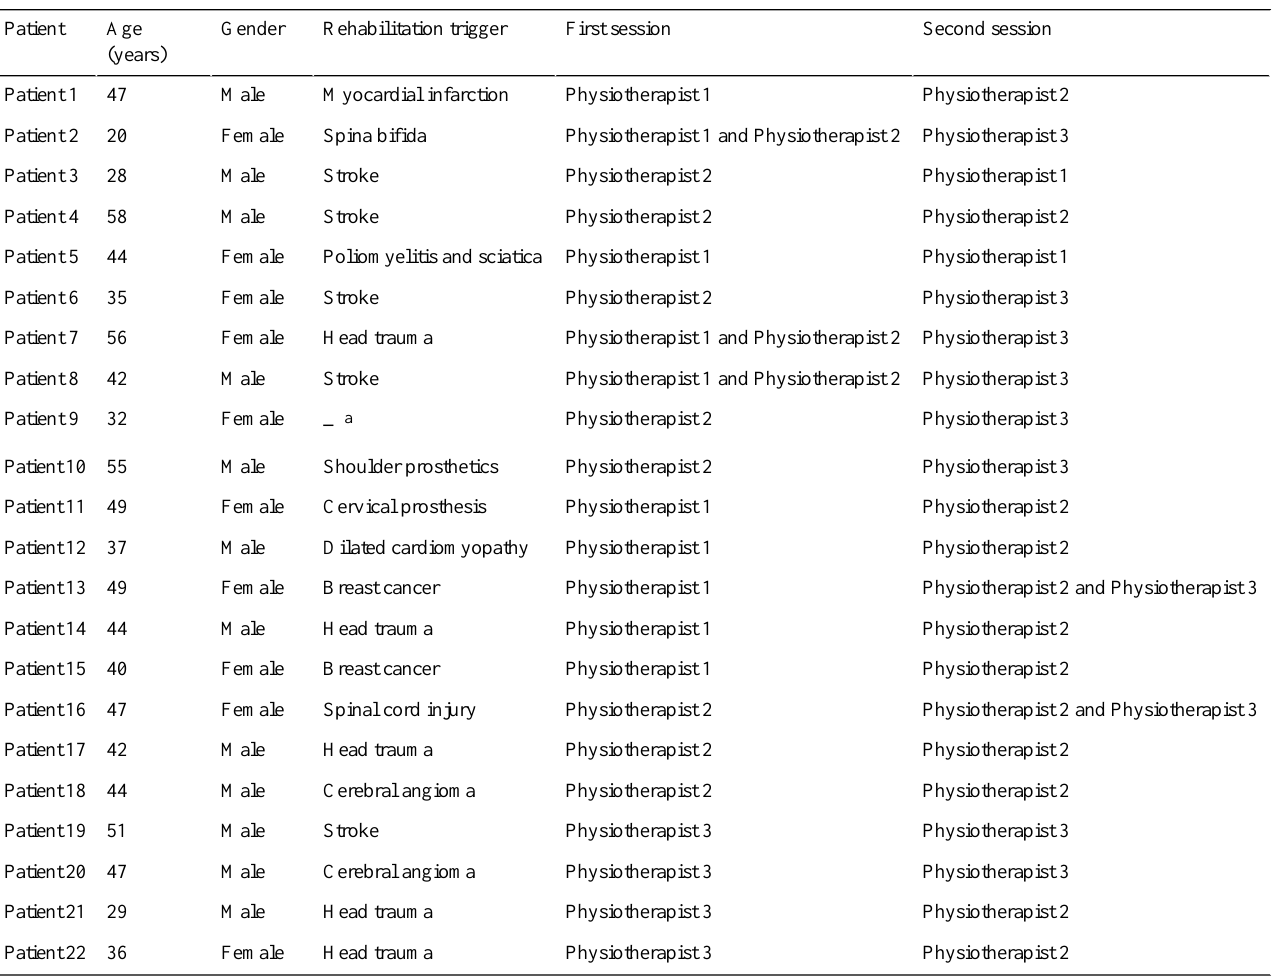
Table 2. Characteristics of patients